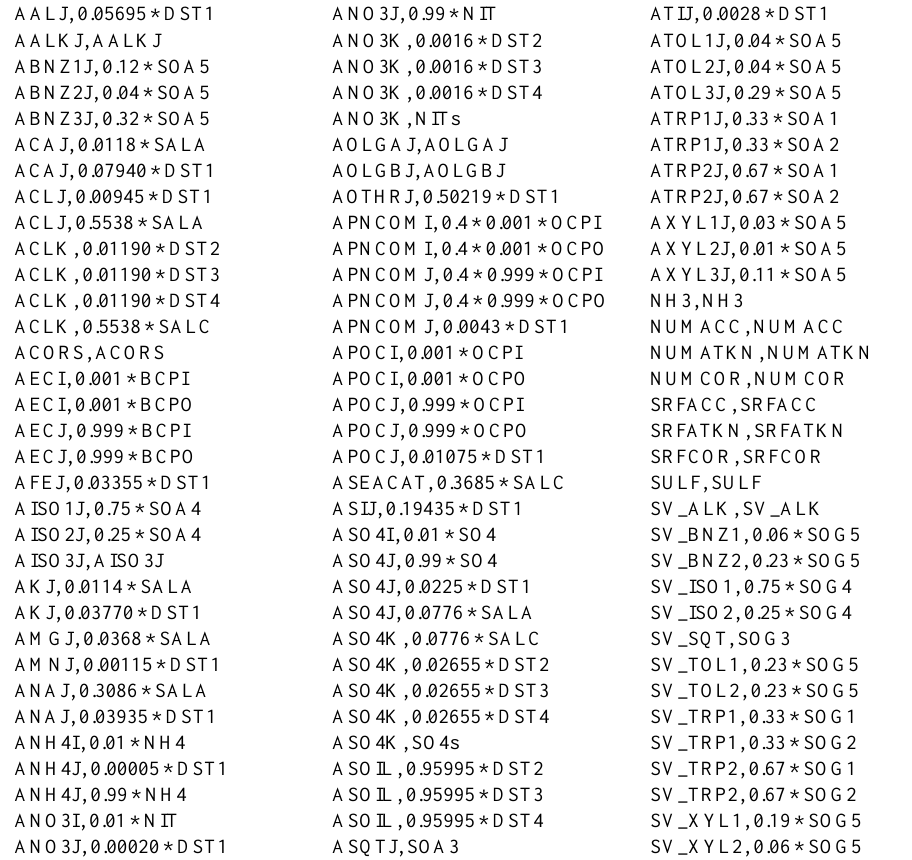
Table A3. CMAQ Aerosols version 6 (AE6) in the form AE6 Species, GEOS-Chem